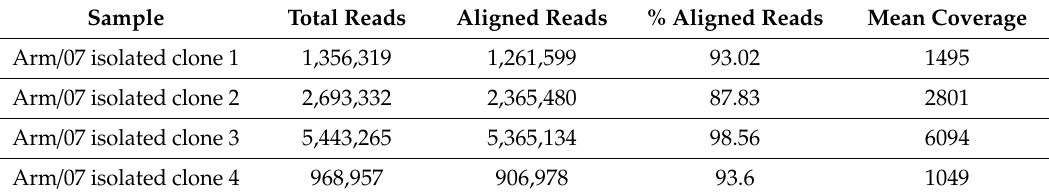
Table 3. Illumina sequencing statistics of ASFV clones isolated from Arm / 07